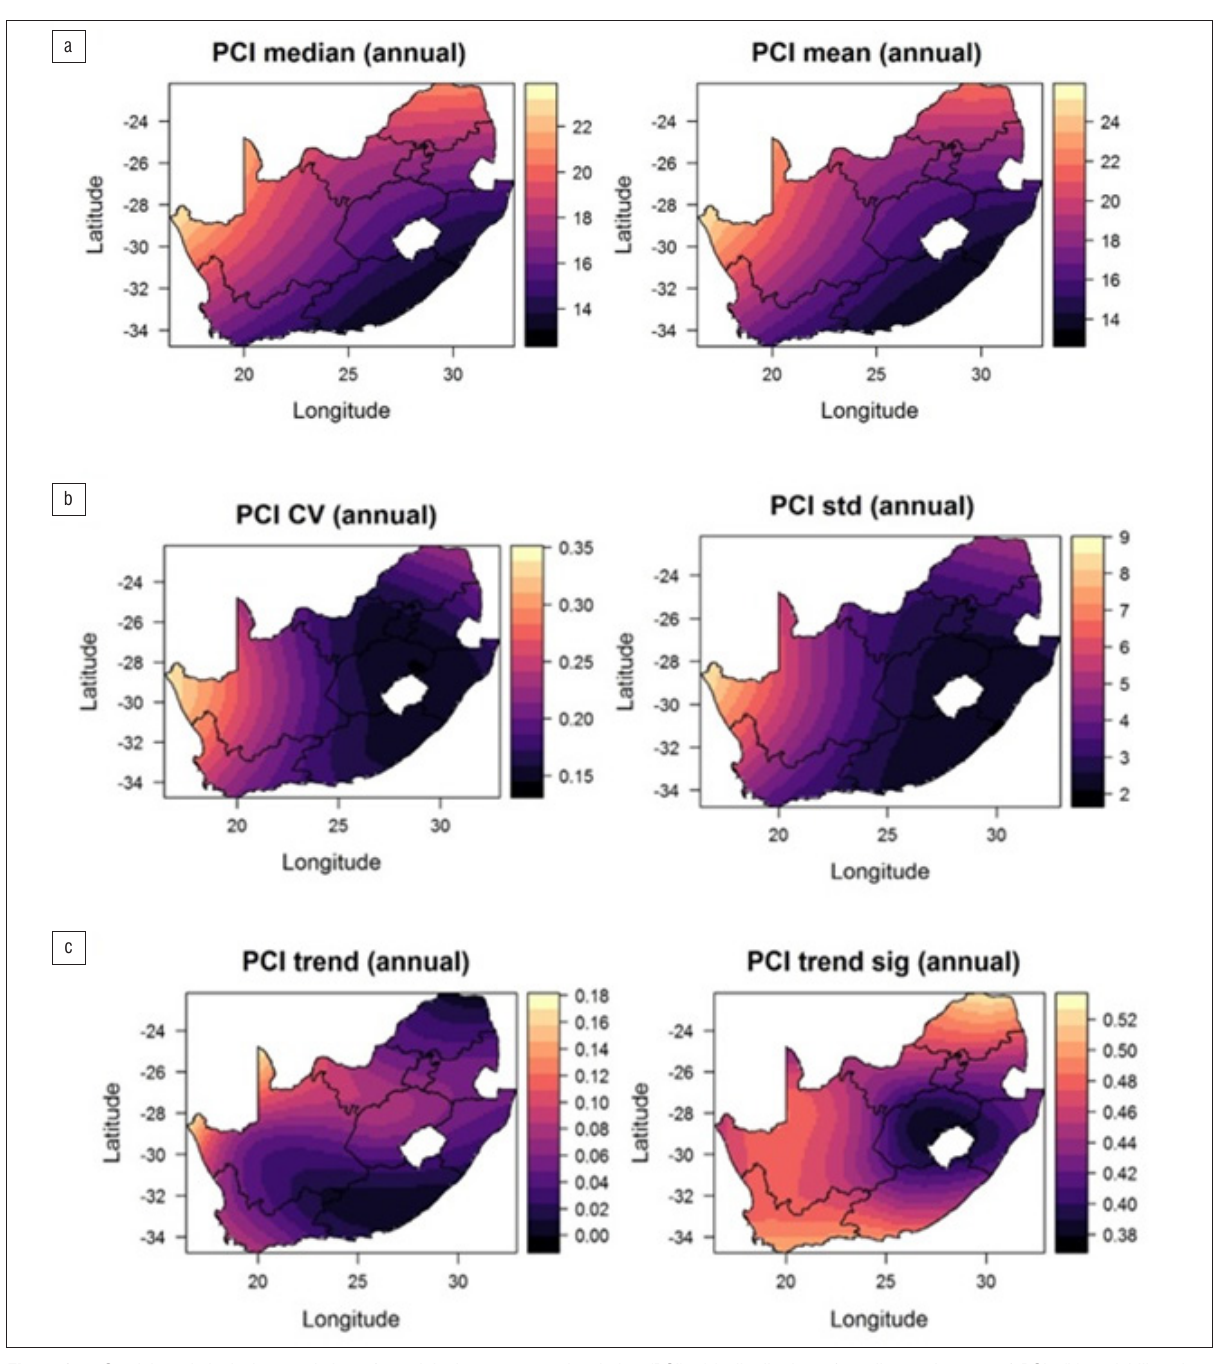
Figure 3 : Spatial statistical characteristics of precipitation concentration index (PCI): (a) distribution of median and mean of PCI; (b) variability given by coefficient of variation (CV) and standard deviation (std) of PCI; and (c) distribution of non-linear pre-whitened PCI trends and its statistical the Northern Cape and Western Cape Provinces, and less variable over the northern regions of the country (e.g. Limpopo Province). The central interior region and parts of the eastern region of the country (i.e. Free State, KZN, Gauteng as well as some parts of the North West and Eastern Cape Provinces) depict lower PCI variability. During the period PCI trends (less than 0.2 mm/year). According to Theil 33 , PCI trends are considered significant if the estimated p -value falls below a critical value (e.g. α <0.05), indicating 95% confidence. Furthermore, negative trends are also observed in small regions of the Eastern Cape and Limpopo Provinces (see Figure 3c). These results corroborate the precipitation trends reported in Kruger and Nxumalo 34 for example.